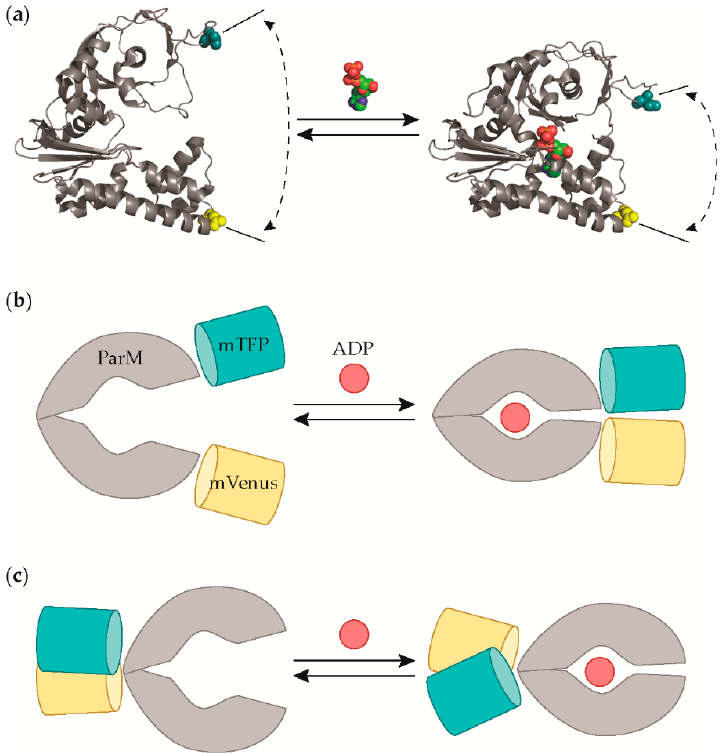
Figure 1. Adenosine diphosphate (ADP) sensor designs. ( a ) The X-ray crystal structures of E. coli ParM